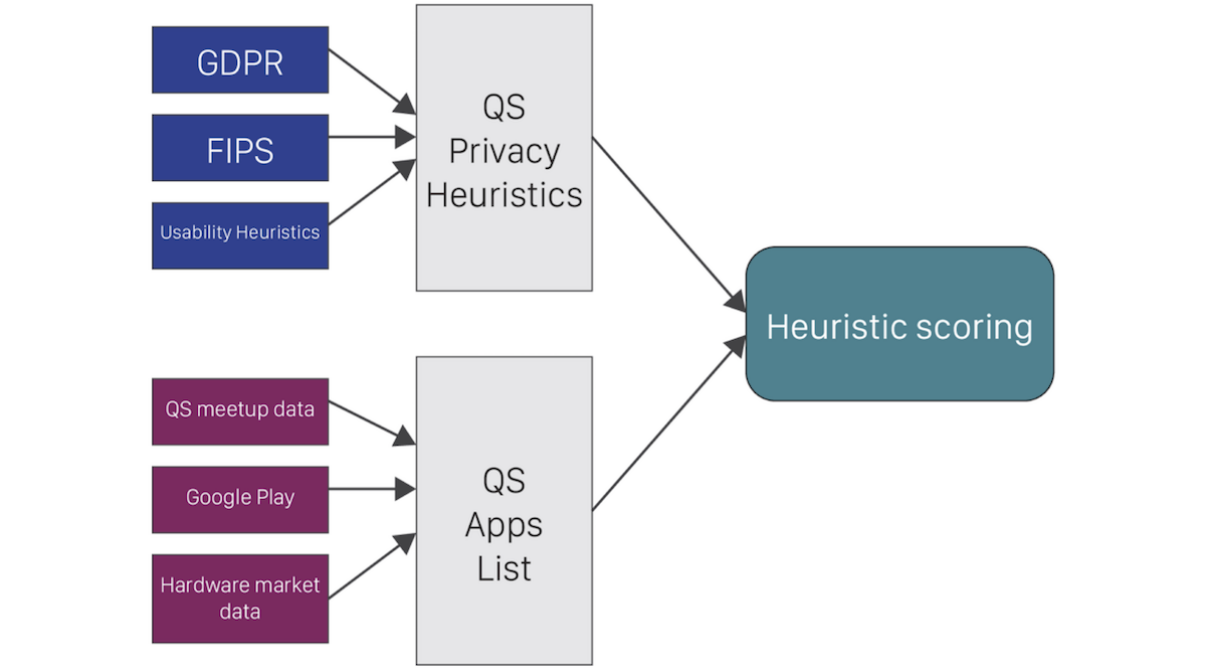
Figure 1. How the regulatory and market landscape was fed into the design of the heuristics and the choice of apps to study. GDPR: General Data Protection Regulation; FIPS: Fair Information Practices; QS: quantified